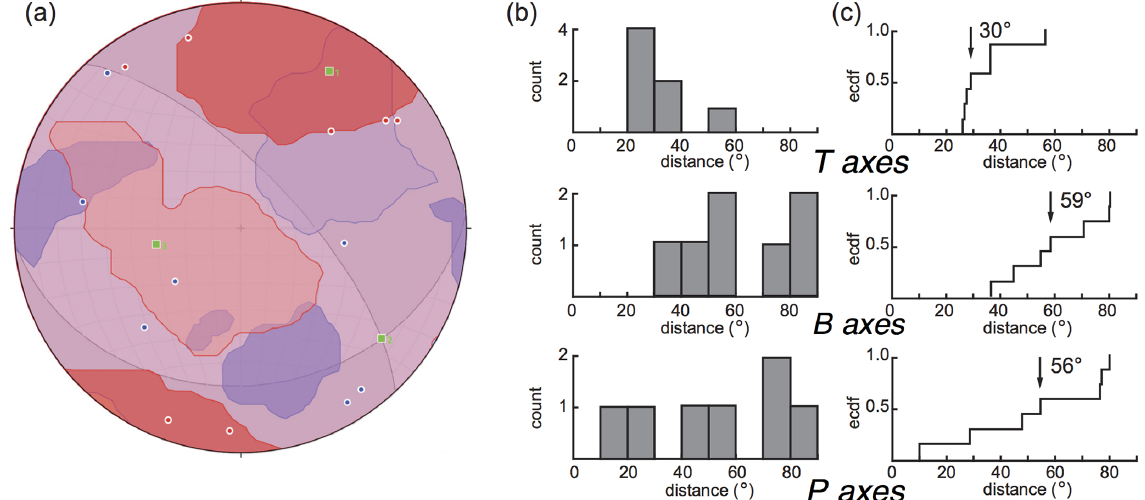
Figure 4. An example of dispersion analysis for data of seismic zone no. 9. (a) The possible cumulative focal mechanism obtained with the summation of all focal mechanisms available for this zone, all strike-slip. Blue and red circles are the P and T axes of input focal mechanisms, and green symbols are the P, T, and B axes of the cumulative one; blue and red areas are P- and T-axis contours. (b) Histograms and (c) cumulative curve of the angular difference between T (top), B (middle), and P (bottom) axes of input and cumulative focal mechanisms. (c) Cumulative plots. Black arrows: median value.